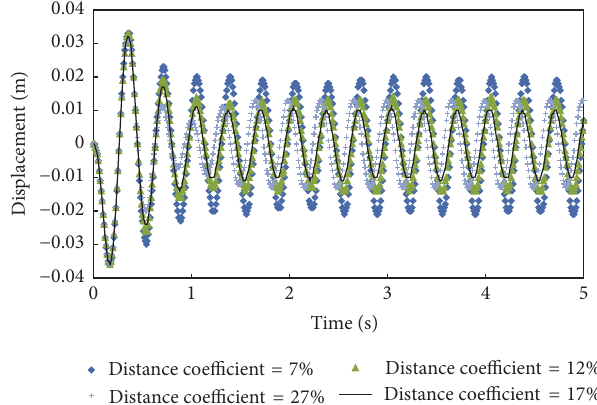
Figure 5: Displacement responses of the modeled offshore platform corresponding to various distance coefficients under sinusoidal waves.